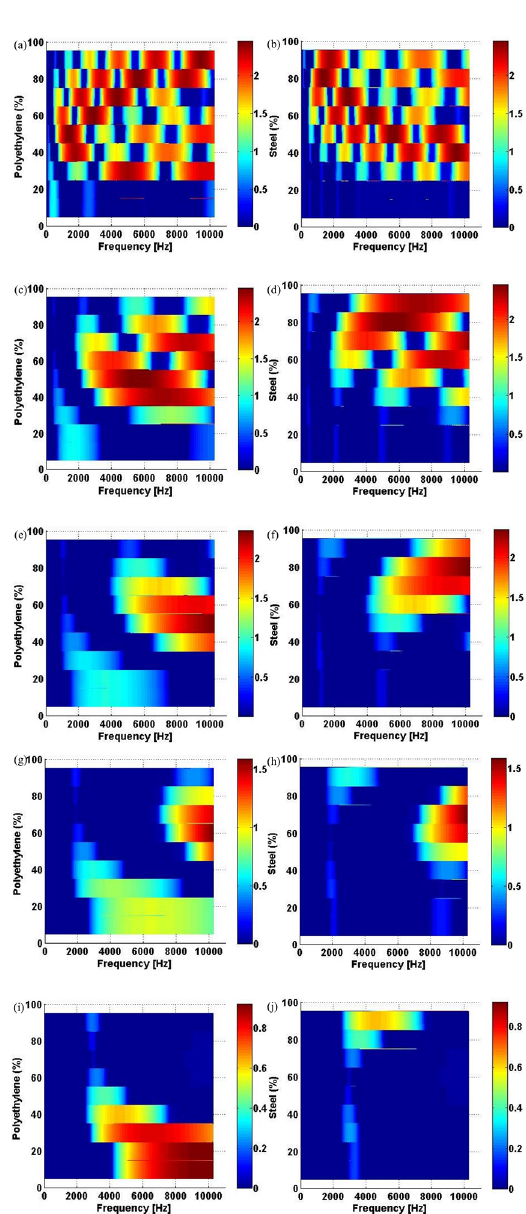
Figure 9. Unit cell attenuation constant surface x-y view of the PC beam considering N (a-b), N = 4 (c-d), N = 6 (e-f), N = 8 (g-h) and N = 10 (i-j), for models 1 (a,c,e,g,i) and 2 (b,d,f,h,j), calculated by WSE method. Figure 11 (a-d) illustrates the displacement of the last beam node (right side), the transmittance and the FRFs H and H , respectively. The numerical results present good 21 agreement with the experimental results, however, FE and WFE methods do not match in higher frequencies with the analytical methods, as discussed before. Furthermore, there is some mismatch related to the experimental